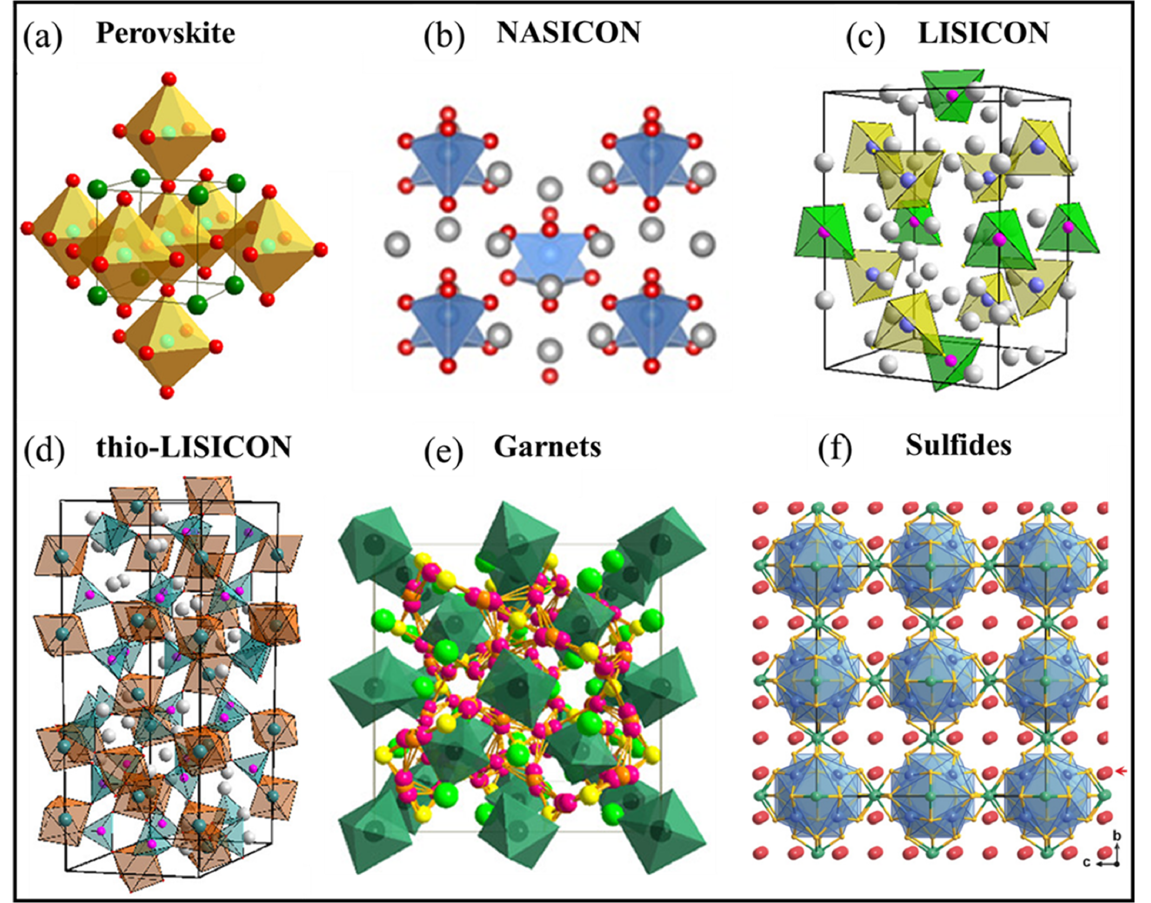
Figure 7. Schematic illustration of the crystal structure of electrolytes: ( a ) Perovskite; ( b ) NASICON [239]; ( c ) LISICON; ( d ) Thio-LISICON; ( e ) Garnets [240]; ( f ) Su fi des